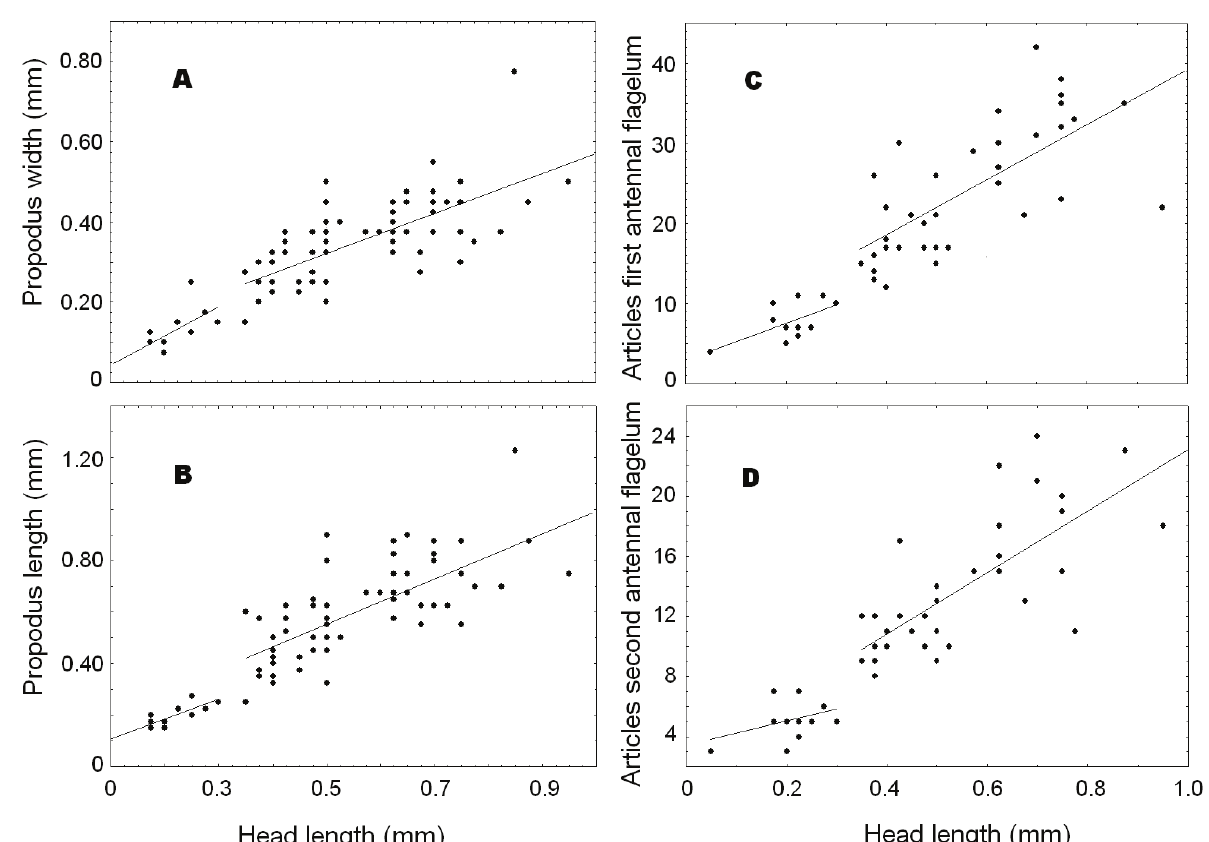
Figure 6. Female relative growth of the width (A) and length (B) of the propodus of the second gnathopods; and the number of articles in the first (C) and second (D) pair of antennal flagella. Discontinuity of the regression lines represents the size-range at which maturity is reached in females of Quadrivisio lutzi . Gnathopods were measured from 75 specimens (66 females and 9 of undefined sex) and flagella articles were counted from 49 specimens (37 females and 12 of undefined